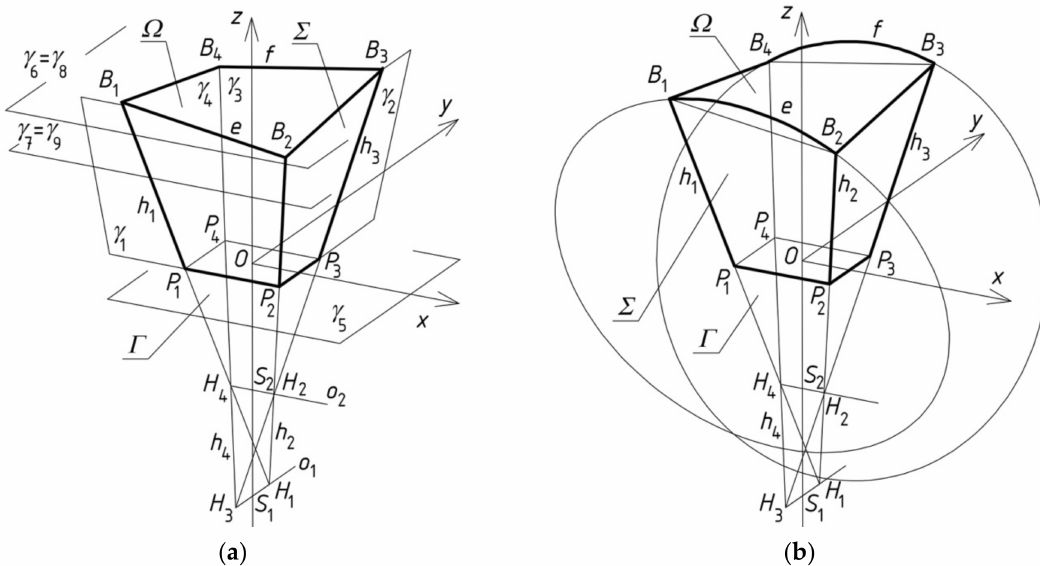
Figure 12. Two simplified models of a free-form building roofed with transformed shells supported by: ( a ) straight directrices; and ( b ) curved